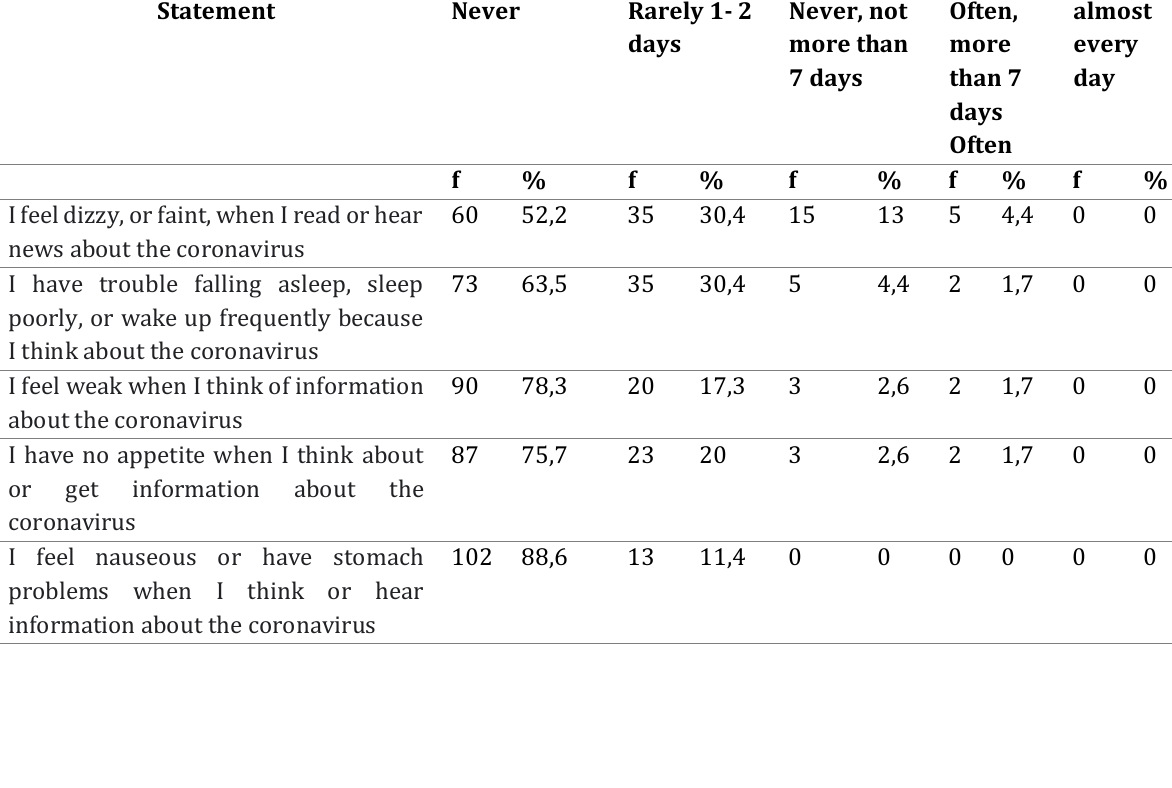
Distribution of public anxiety statements due to the COVID-19 pandemic (n =